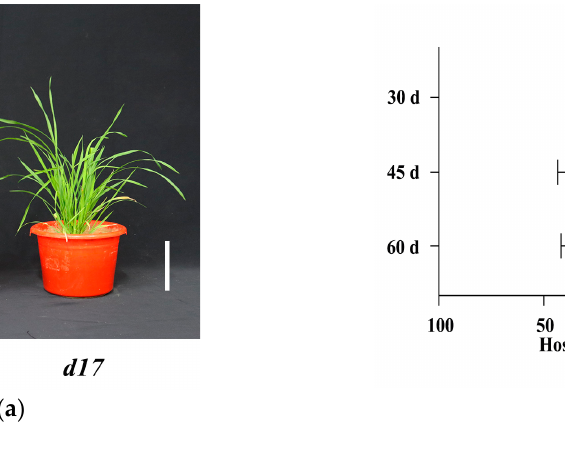
Figure 2. ( a ) Morphologies of the WT and d17 rice plants at tiller stage. The scale bar is 10 cm. ( b ) Olfactory response of WBPHs to the WT and d17 plants in the Y-tube olfactometer. Average (±SD) values from three biological replicates. Significant differences were calculated using the chi-squared test for dependent samples, * p < 0.05, ** p < 0.01.